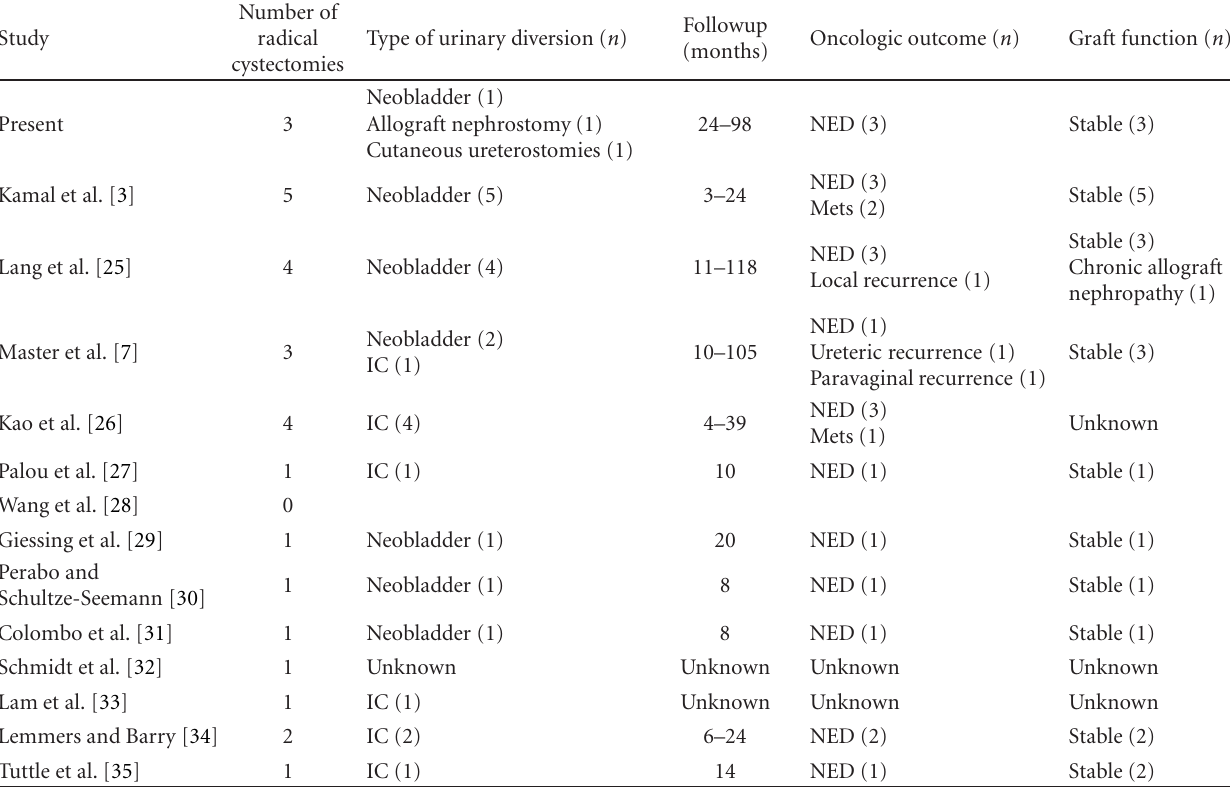
Table 3: Summarized data on all cases of radical cystectomy and urinary diversion performed for postrenal transplant bladder cancer